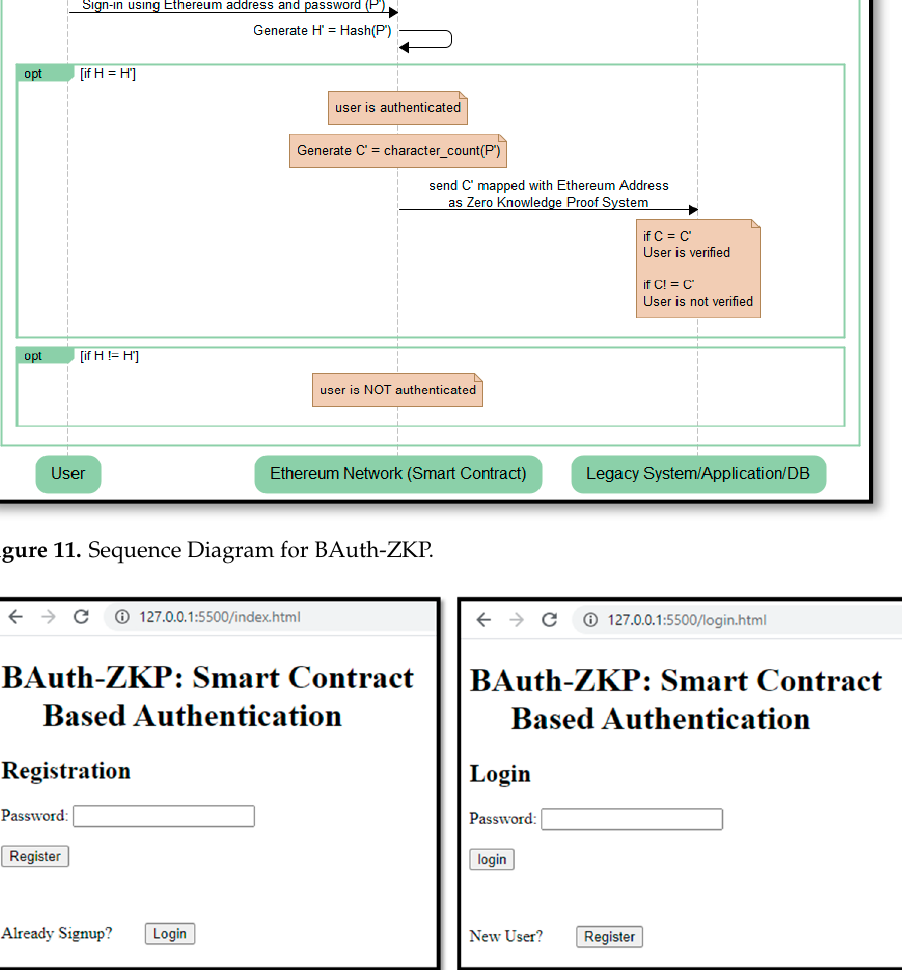
Figure 13. Confirmation window during the registration transaction using Metamask Wallet.